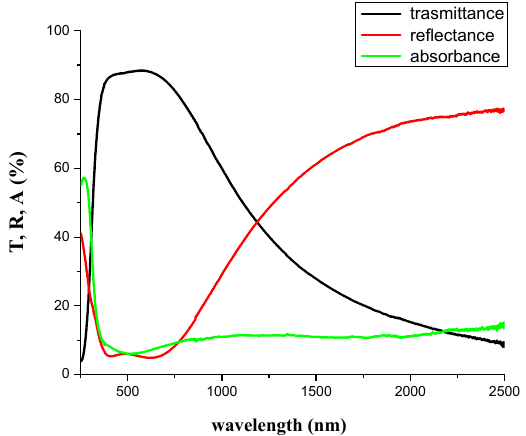
Figure 9. Transmittance, reflectance, and absorbance of AlN_Ag2 sample.